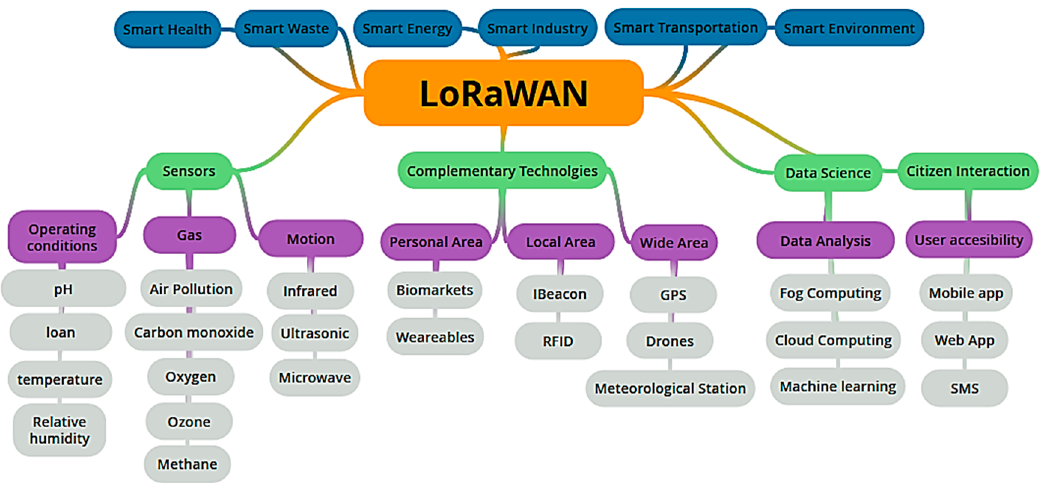
Figure 11. Components of IoT ecosystems in smart city applications. RFID: